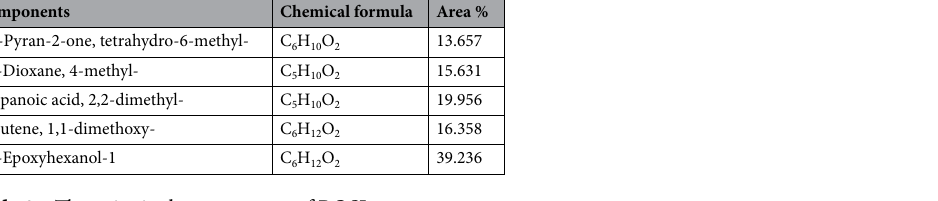
Table 3. The principal components of